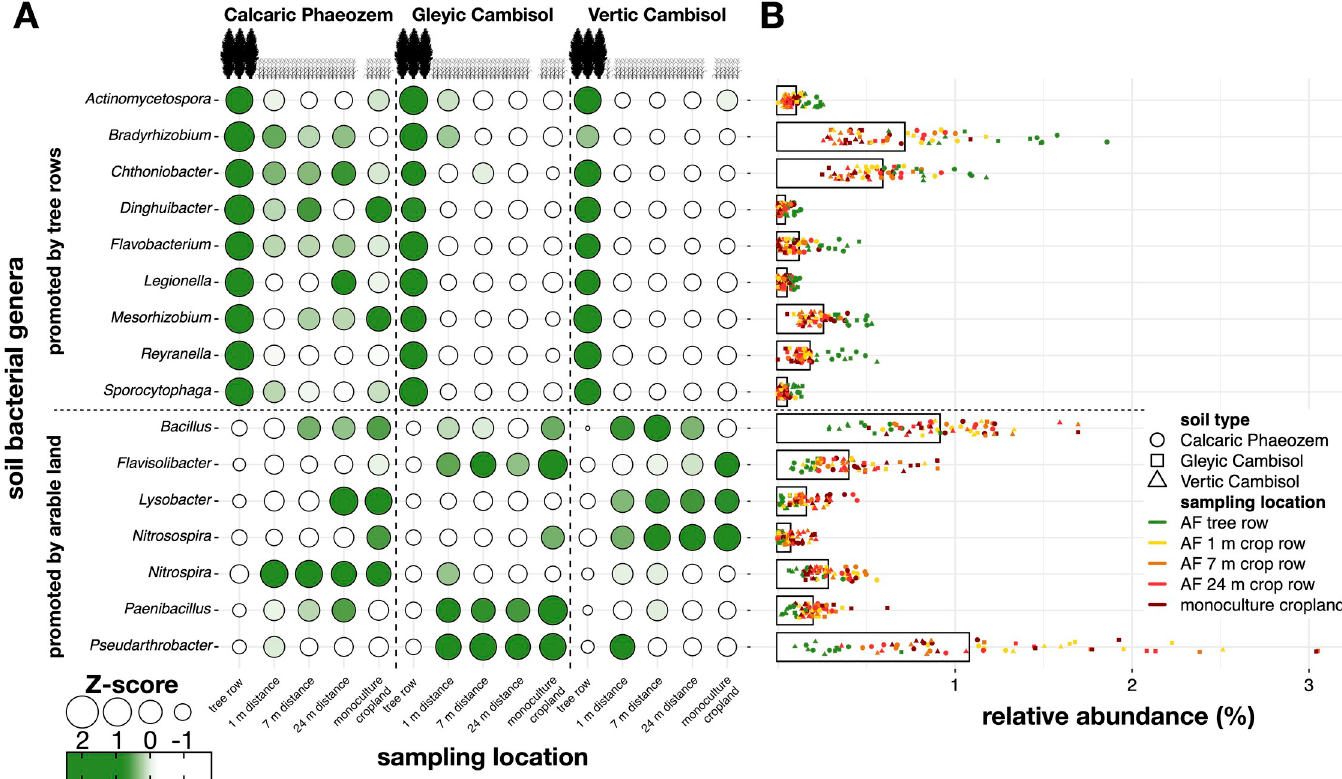
Fig 5. Z-score normalized relative abundance ( A ) and relative abundance ( B ) of selected taxonomic soil bacterial genera in paired temperate agroforestry and monoculture cropland systems in three different soil types. Samples in the agroforestry systems were collected in the tree row as well as at 1 m, 7 m, and 24 m distance from the tree row within the agroforestry crop row. Horizontal bars represent the mean relative abundance, coloured shapes represent individual data points ( B ).